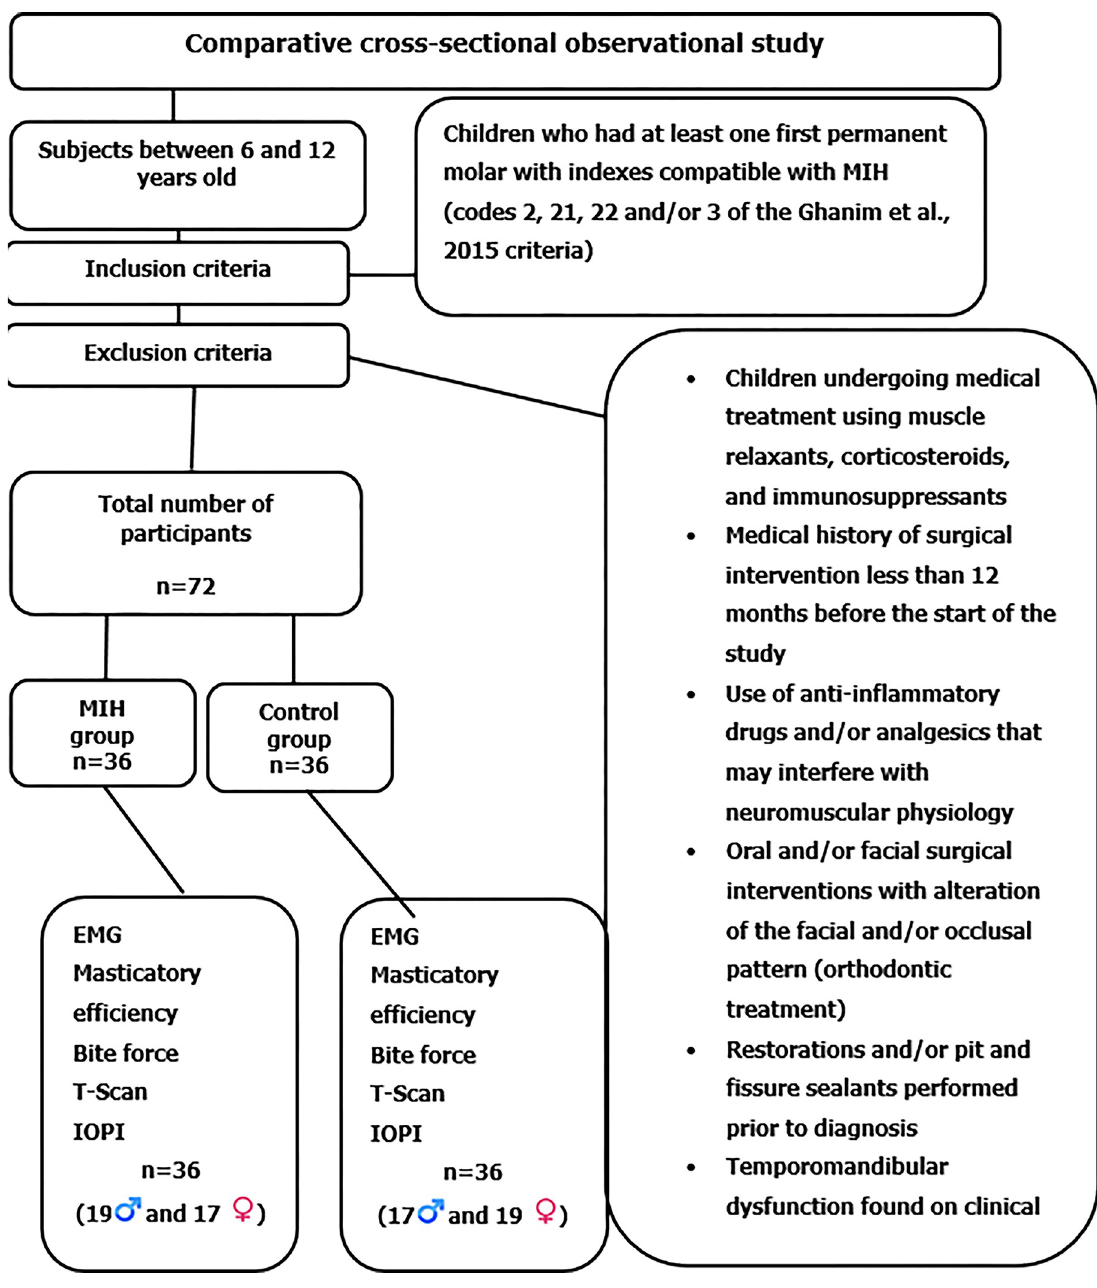
Fig 1. Diagram of the study population